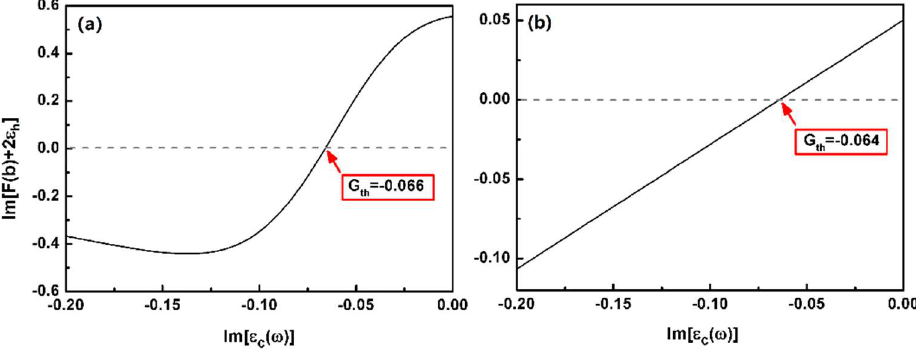
Figure 8. Real ( a ) and imaginary ( b ) parts of ε c ( ω ) in the case of a high aspect ratio ( a / b = 0.8) of Figure 2g with ε cg = − 0.07 and h = 0.3. ( c ) The same as Figure 4a but using the present ε c ( ω ) . Parameters: τ = 10 − 14 s, ω g = ω + = 2 π c / λ + , λ + = 617.4 nm.